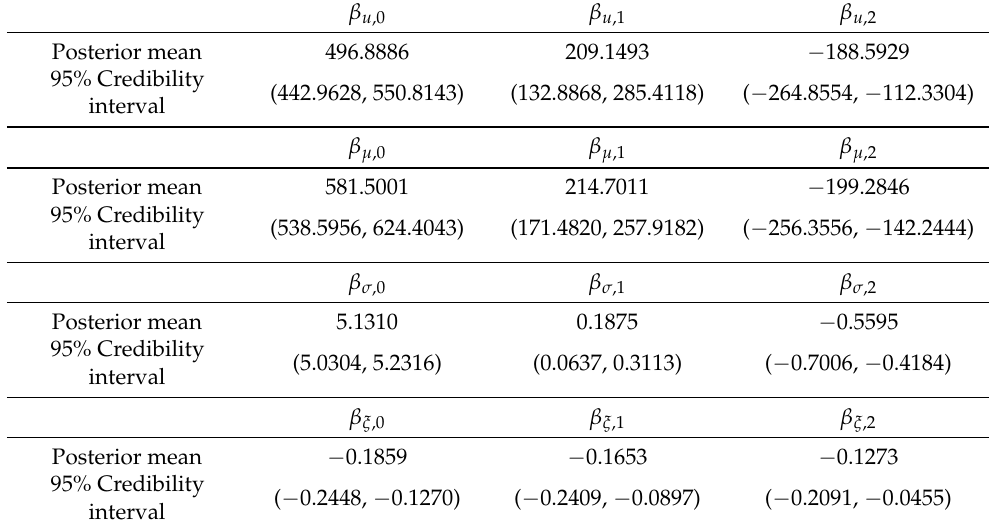
Table 4. Estimates and 95% credibility interval for the regression coefficients of the Iowa river monthly flow. β u ,0 β u ,1 β u